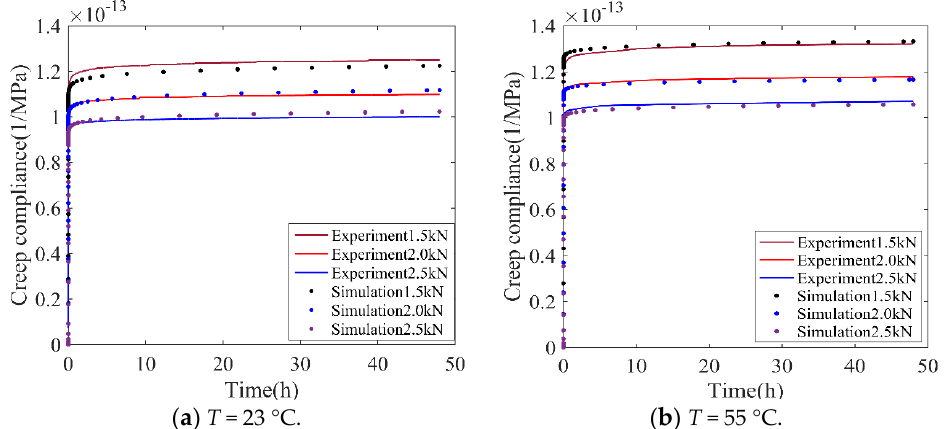
Figure 13. Comparison of numerical and experimental creep compliance.